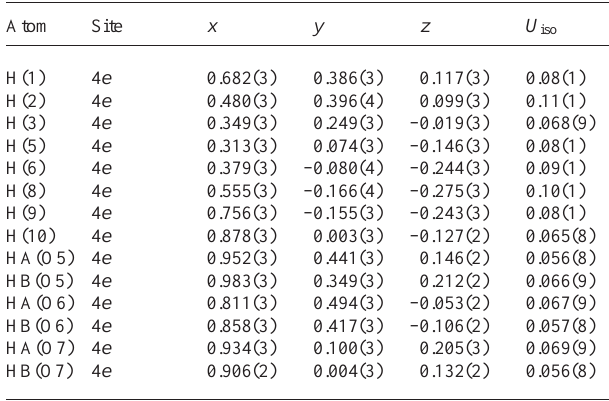
Table 2. Atomic coordinates and displacement parameters (in Å 2 )